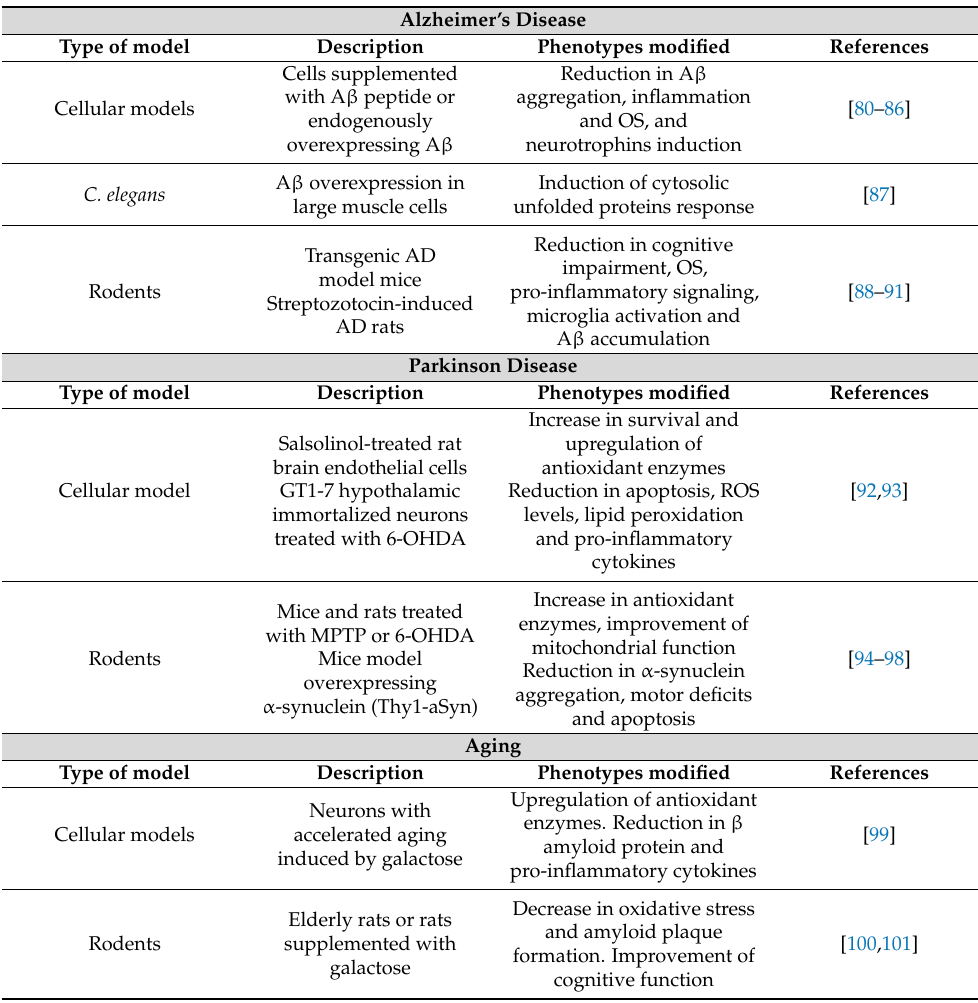
Table 2. Beneficial effects of carnosine supplementation in models of Alzheimer’s disease, Parkinson’s disease and